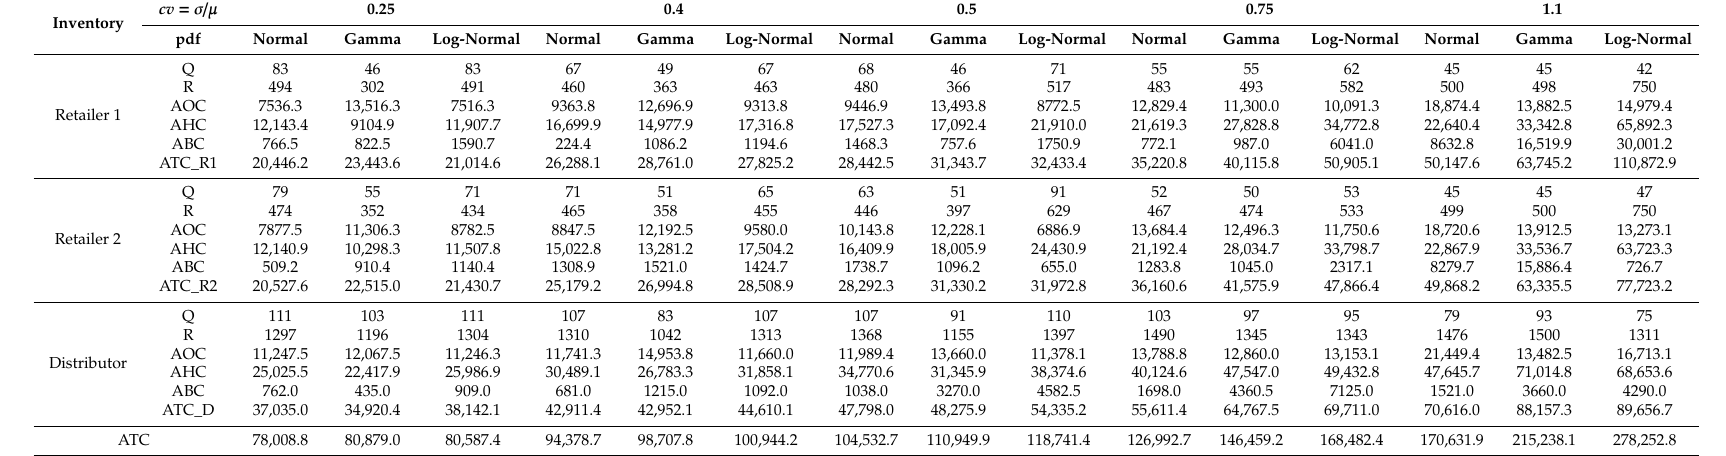
Table 6. Results for di ff erent types of normal, gamma, and log-normal